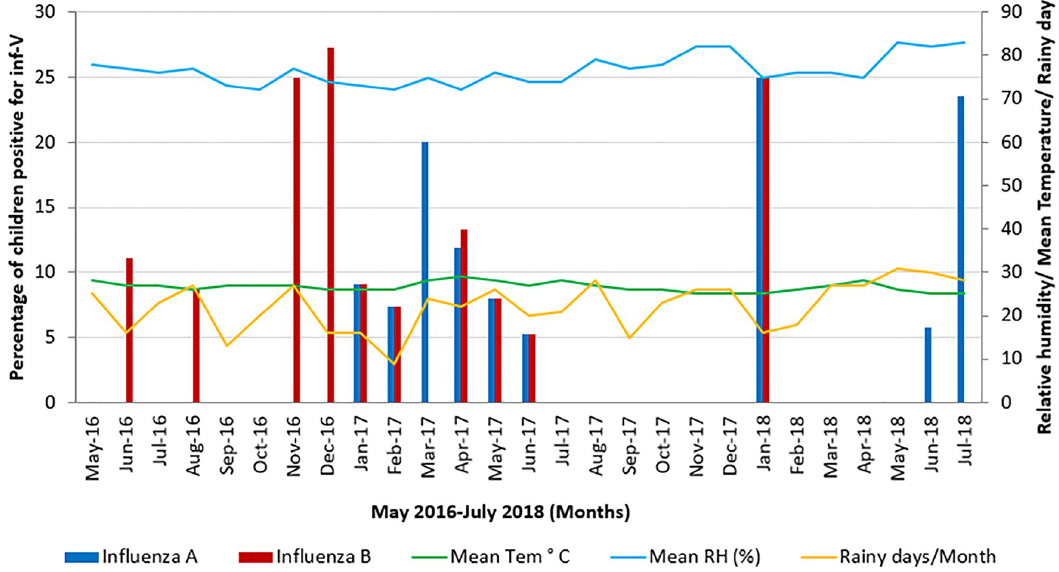
Fig 3. Monthly distribution of Inf-V in children with ARI. Monthly distribution of the Inf-V infection in children from May 2016 to July 2018. The months of November to December 2016, March 2017 and June to July 2018 had children with high percentage of Inf-V infection on admission to Teaching Hospital, Kegalle Sri